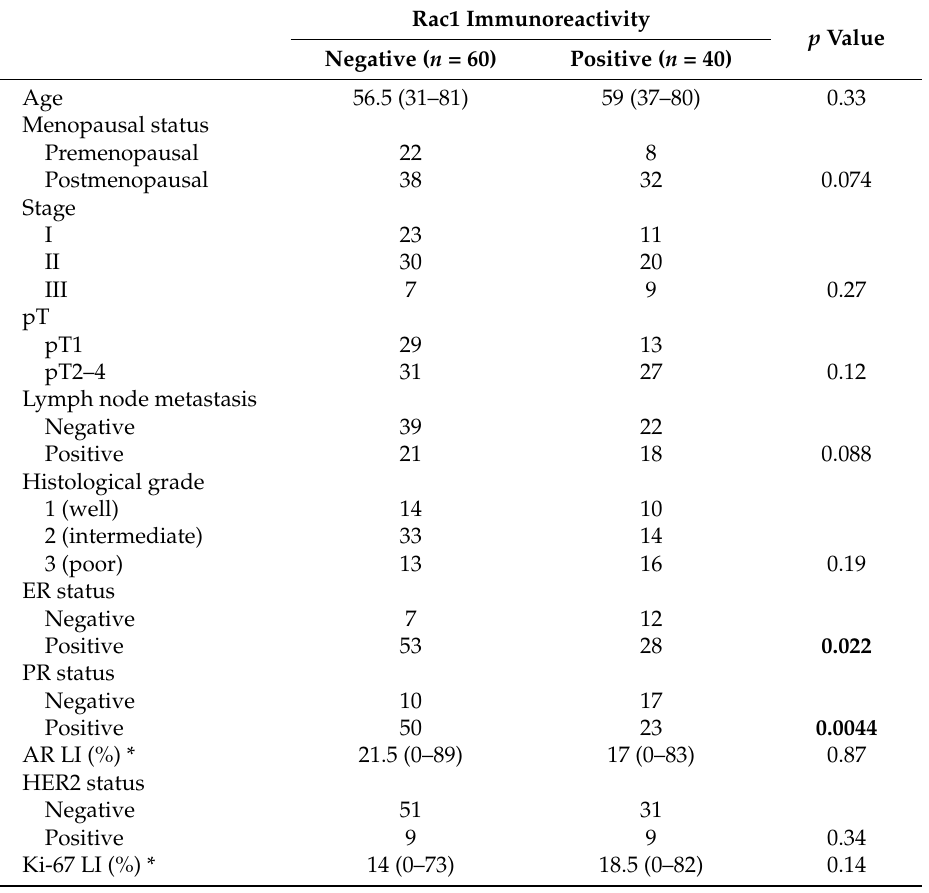
Table 2. Association between Rac1 immunoreactivity and clinicopathological parameters in breast carcinoma patients ( n =